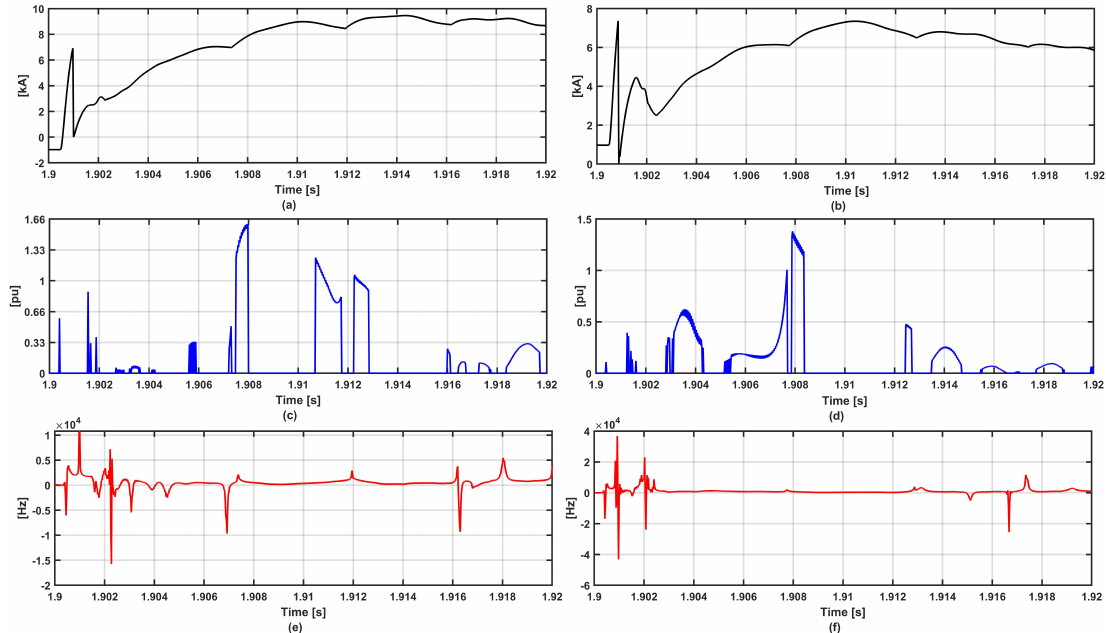
Figure 6. Simulation results for fault II. ( a ): RP3 current ( b ): RP4 ( c ): Instant amplitude for RP3 ( d ): Instant amplitude for RP4 ( e ): Instant frequency for RP3 ( f ): Instant frequency for